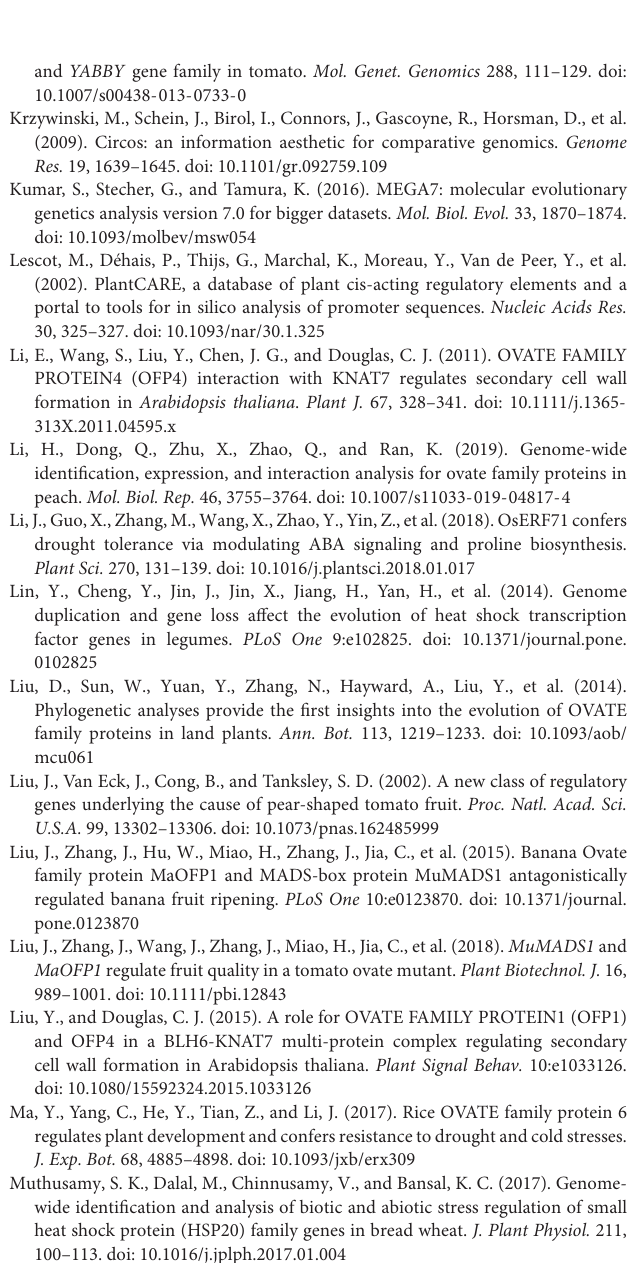
Supplementary Figure 1 | Amino acid sequence alignment of Populus OVATE domain. Supplementary Figure 2 | Microsynteny analyses of OFP genes among P. trichocarpa , O. sativa, and A. thaliana. Supplementary Figure 3 | Chromosomal distribution of PtOFP genes in the genome of Populus trichocarpa . Supplementary Figure 4 | The detail motif logos of PtOFPs. Supplementary Figure 5 | Real-time PCR analysis of 16 PtOFP genes in three Populus tissues (root, stem, and leaf). PtUBC was used as an internal control. The 2 − (cid:49)(cid:49) Ct method was used to calculate the relative expression levels of the target genes. The error bars indicate the standard deviation obtained from three replicates.